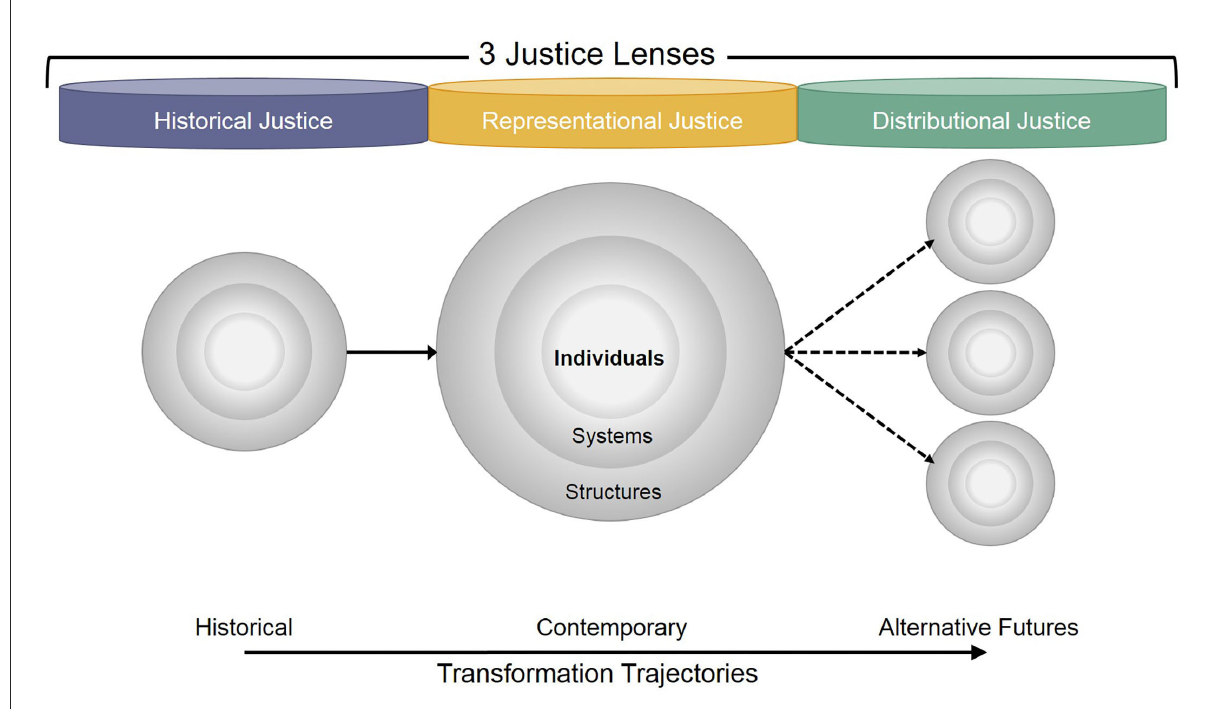
FIGURE2 Food systems transformation and justice reproduced and adapted from Whitfield et al.